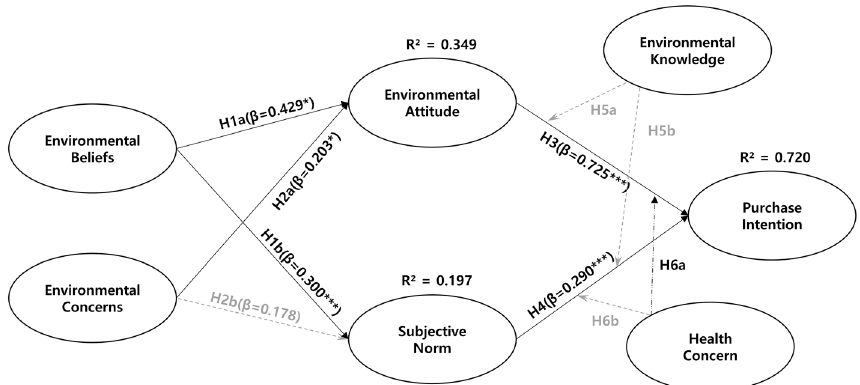
Fig. 1 Research model of results. ***p < 0.001, **p < 0.01, *p < 0.05. The model fit indices: χ 2 (df